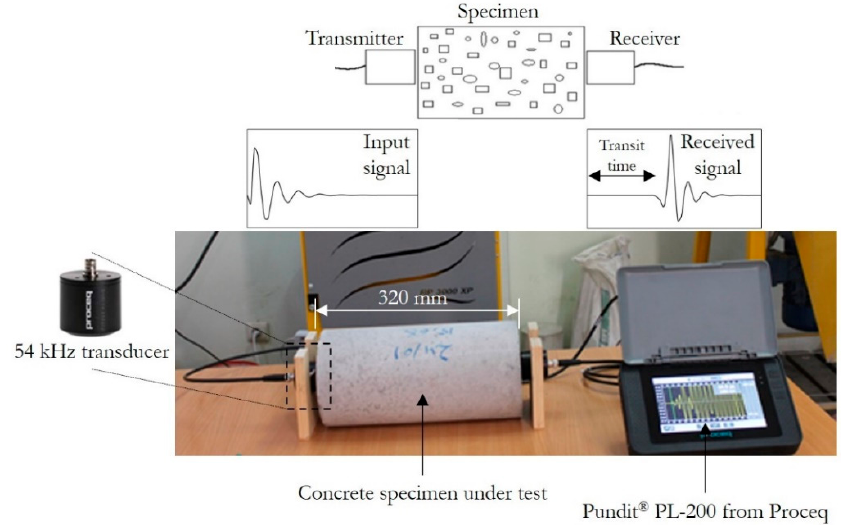
Figure 3. NDT techniques for concrete structures.